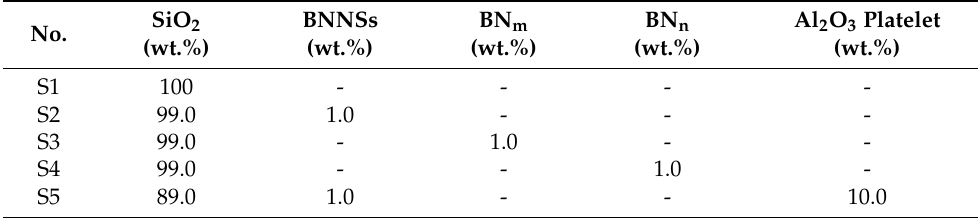
Table 1. Composition of the